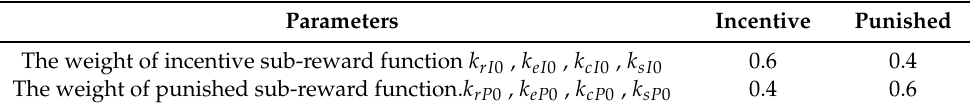
Table 3. Weight coefficient of the incentive-punished-weighted coefficient matrix. Parameters Incentive